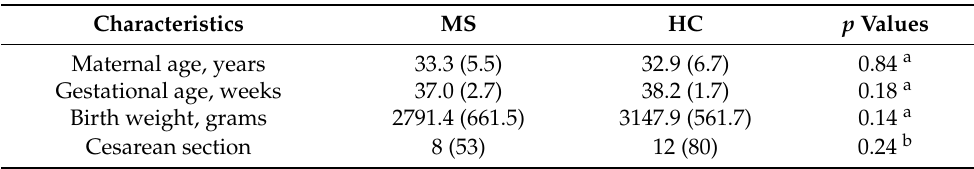
Table 1. Characteristics of the women